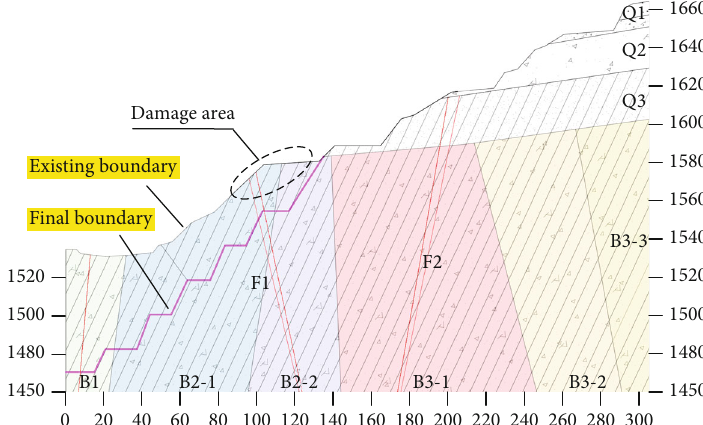
Figure 2: Typical A-A failure section of the Southwest stope.